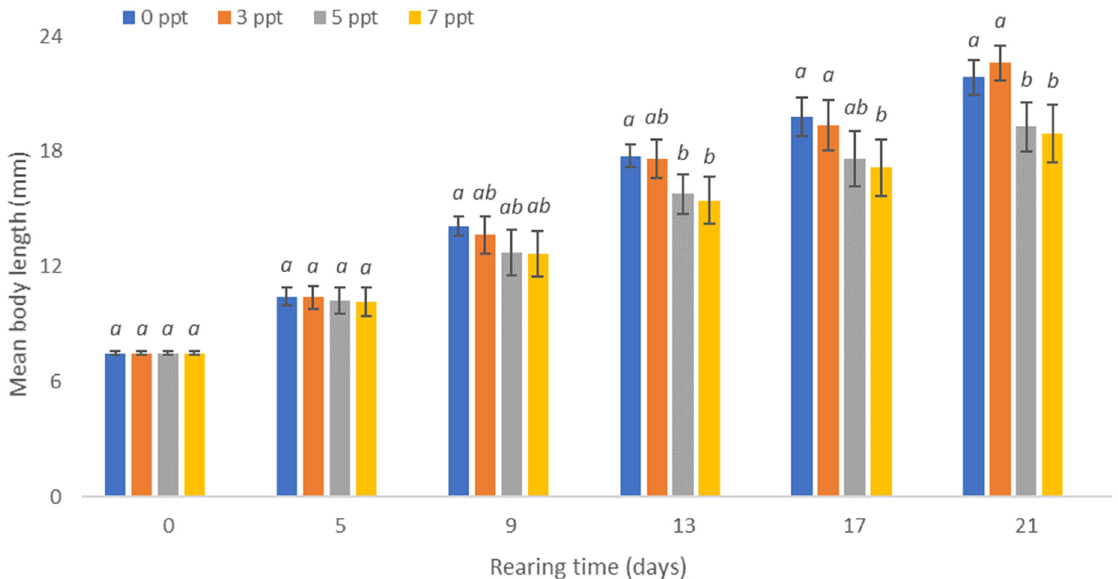
Figure 3. Increase in the body length of the blue bream Ballerus ballerus (L.) larvae reared in freshwater and in water with salinity of 3, 5, and 7 ppt. The same letter indexes above the columns in a given sample mean that the values are not statistically significantly different ( α = 0.05).